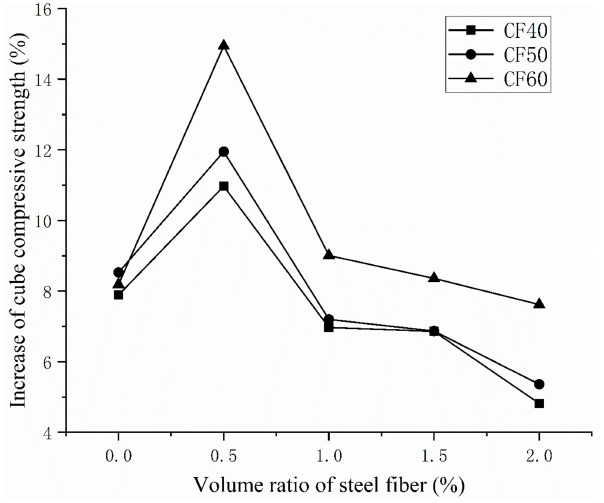
Figure 6. The improvement of the cubic compressive strength of vibration mixing compared with ordinary